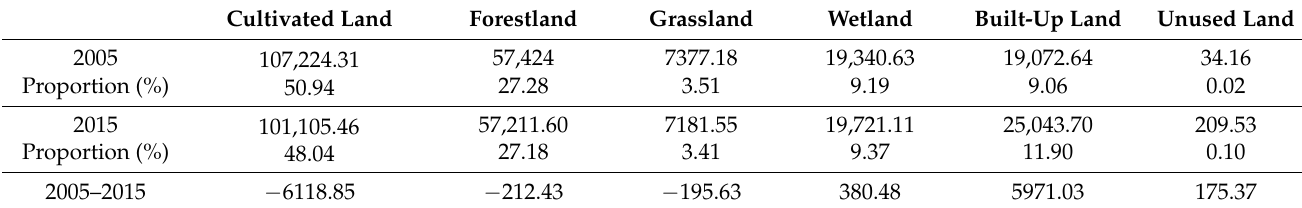
Table 2. Area of various land cover types in the YRD region in 2005 and 2015 (km 2 ). Cultivated Land Forestland Grassland Wetland Built-Up Land Unused Land